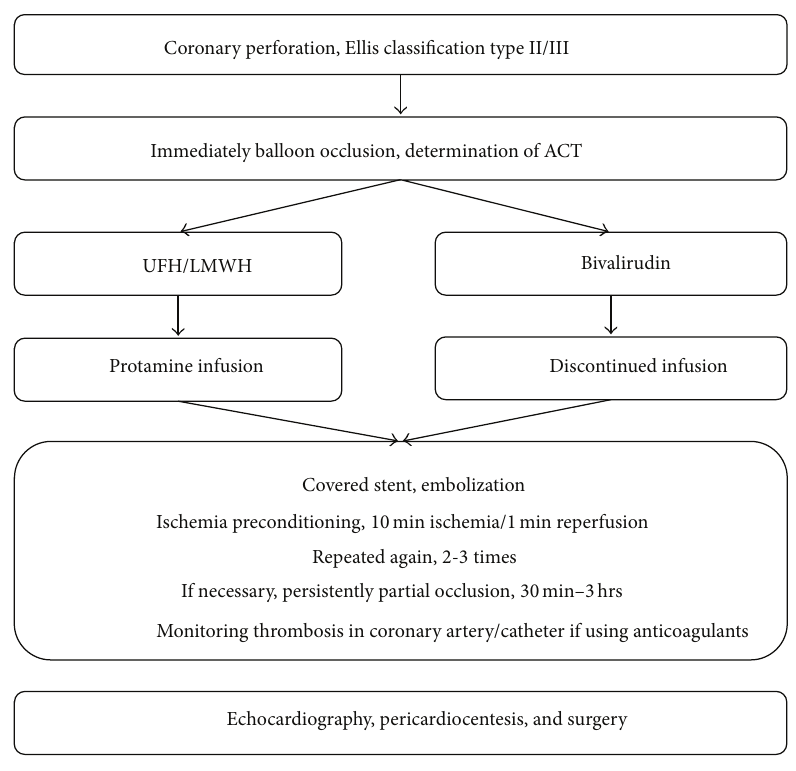
Figure 1: Schematic of recommended CAP